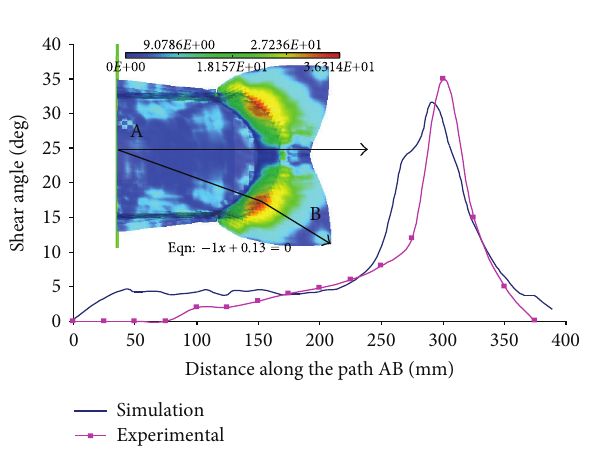
F 23: Experimental and predicted shear angles along the diagonal line